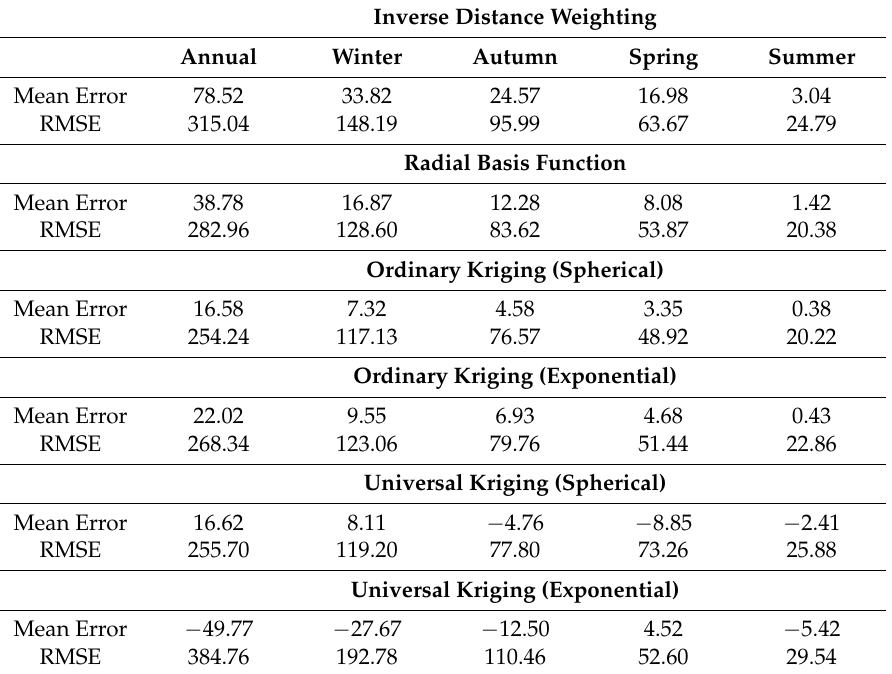
Table 8. Cross-validation results from the interpolation of annual and seasonal